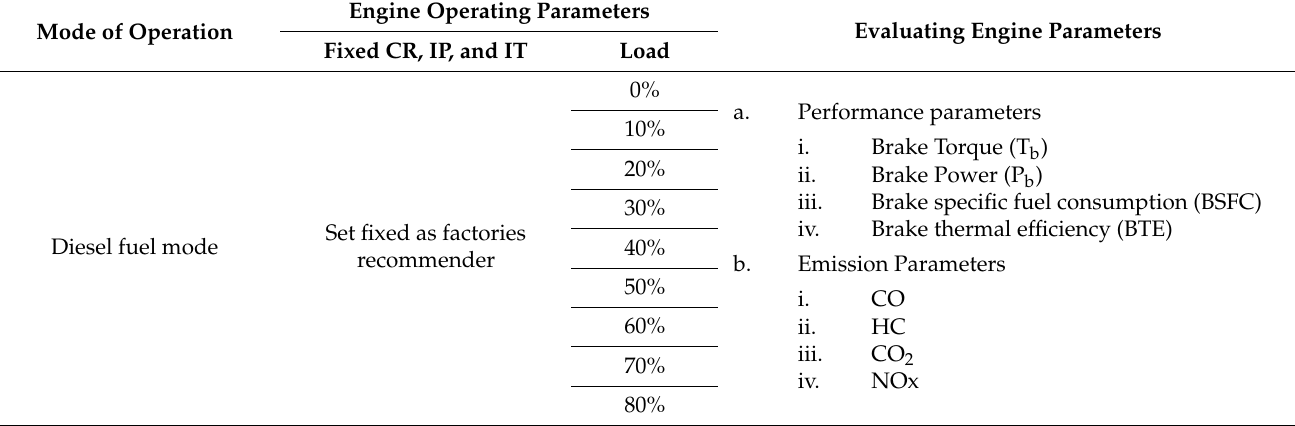
Table 4. Baseline data experimental test matrix.